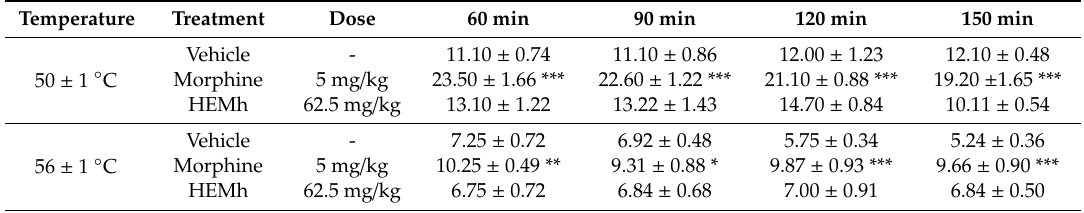
Table 4. Effects of hydroalcoholic extract from the twigs of Machaerium hirtum (HEMh) on the response latency (s) at 60, 90, 120, and 150 min after the administration of two different temperatures in the hot-plate test in mice.